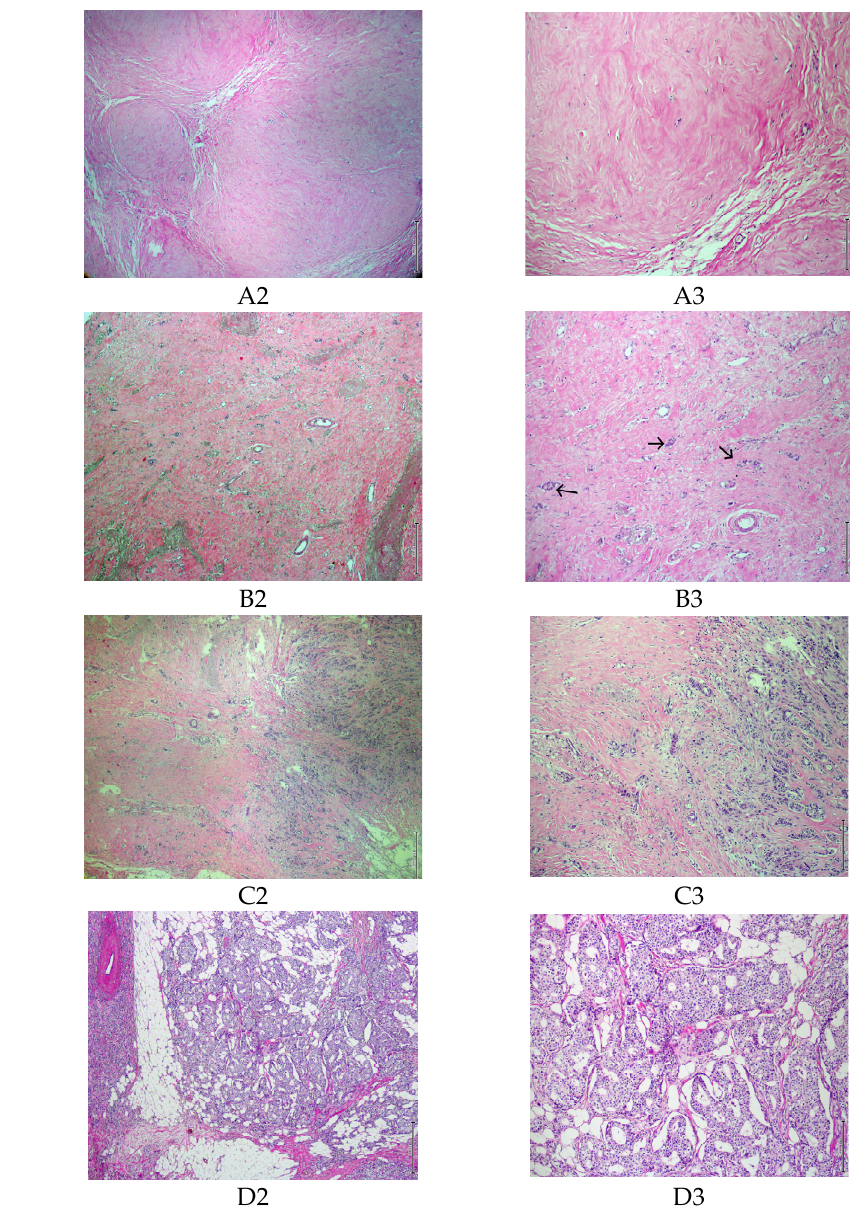
Figure 2. The study recruitment status of 169 patients with breast cancer according to the pathological response degree to NACTx. ( A1 ) IBC on CNB, (×100, HE). ( A2 , A3 ) pCR (n = 41, excluded), microscopic appearance of the tumor bed after NACTx. Tumor bed with no residual tumor, characterized by stromal fibrosis and hyalinization, (×40 and ×100, HE). ( B1 ) IBC on CNB, (×100, HE). ( B2 , B3 ) MRD with <10% of tumor remaining (n = 26, excluded). Stromal fibroelastosis and small clusters of residual invasive tumor cells (arrows), (×40 and ×100, HE). ( C1 ) IBC on CNB, (×100, HE). ( C2 , 3 ) Partial response (n = 71, included). Some degree of fibrosis with residual tumor, (×40 and ×100, HE). ( D1 ) IBC on CNB, (×100, HE). ( D2 , D3 ) No response to NACTx (n = 31, included), lumpectomy sample after NACTx, (×40 and ×100, HE). pCR: pathological complete response; MRD: minimal residual disease; NACTx: neoadjuvant chemotherapy; IBC: invasive breast carcinoma; CNB: core needle biopsy; HE: hematoxylin eosin.